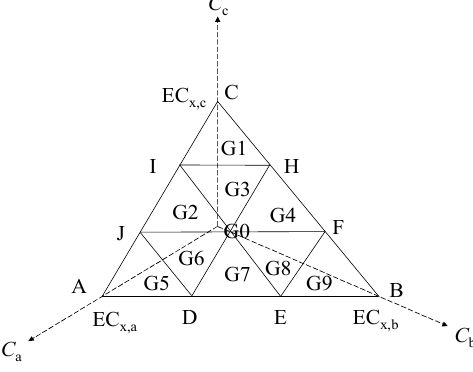
Figure 5. Equipartition equivalent-surface design (EESD) for ternary mixture.